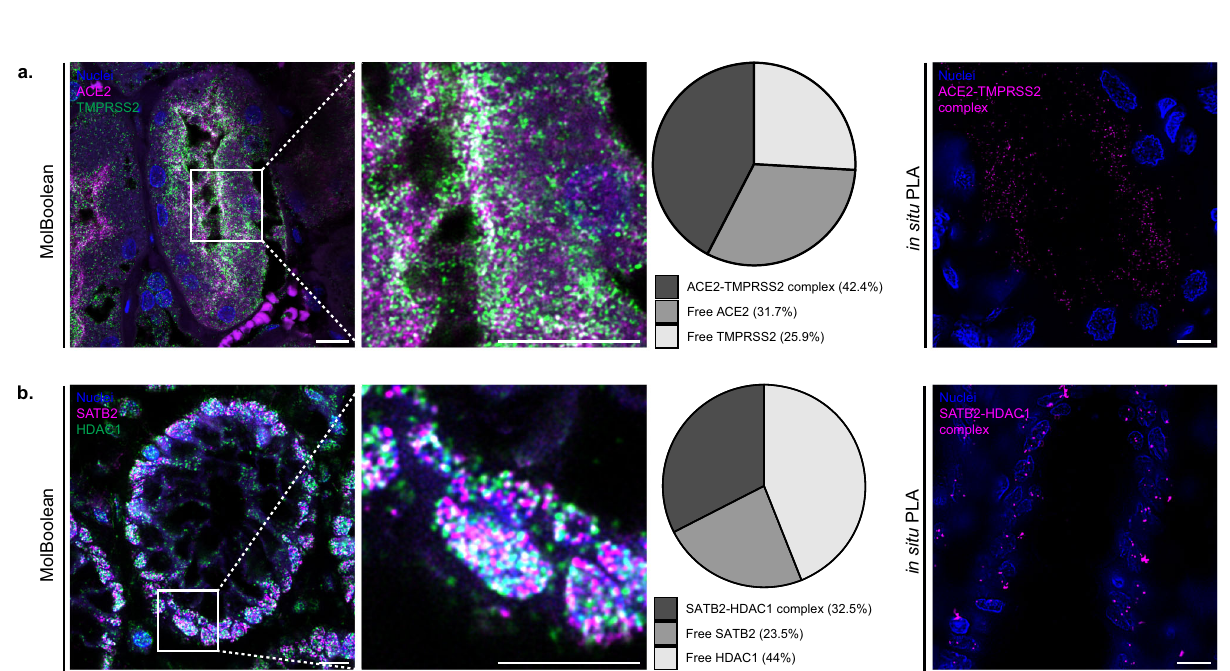
respectively (MolBoolean); p =3.85e − 22 (in situ PLA)). MolBoolean signals are shownforClathrin(magenta),PDGFR- β (green),Clathrin-PDGFR- β complex(white) and nuclei (blue). In situ PLA signals for Clathrin-PDGFR- β complex are shown in magenta and nuclei in blue.White framesdepict an areashown inenlarged view in the following panel. Scale bars = 10 μ m. Quanti fi cation of protein complexes and free proteins (MolBoolean) or protein complexes only (in situ PLA) shown as number of RCPs per cell. n control =103, n knock-down =104 cells ( a ). n control =150, n treated =140 cells ( b ). Data pooled from three independent experiments. Two- sided Wilcoxon rank sum test was used to analyze statistical variance. Box plots show median, Q1to Q3range, lowerand upper whiskersatmaximum 1.5 times the interquartile range. Outliers shown as solid circles. **** p <0.0001. Source data are provided as a Source Data fi le.